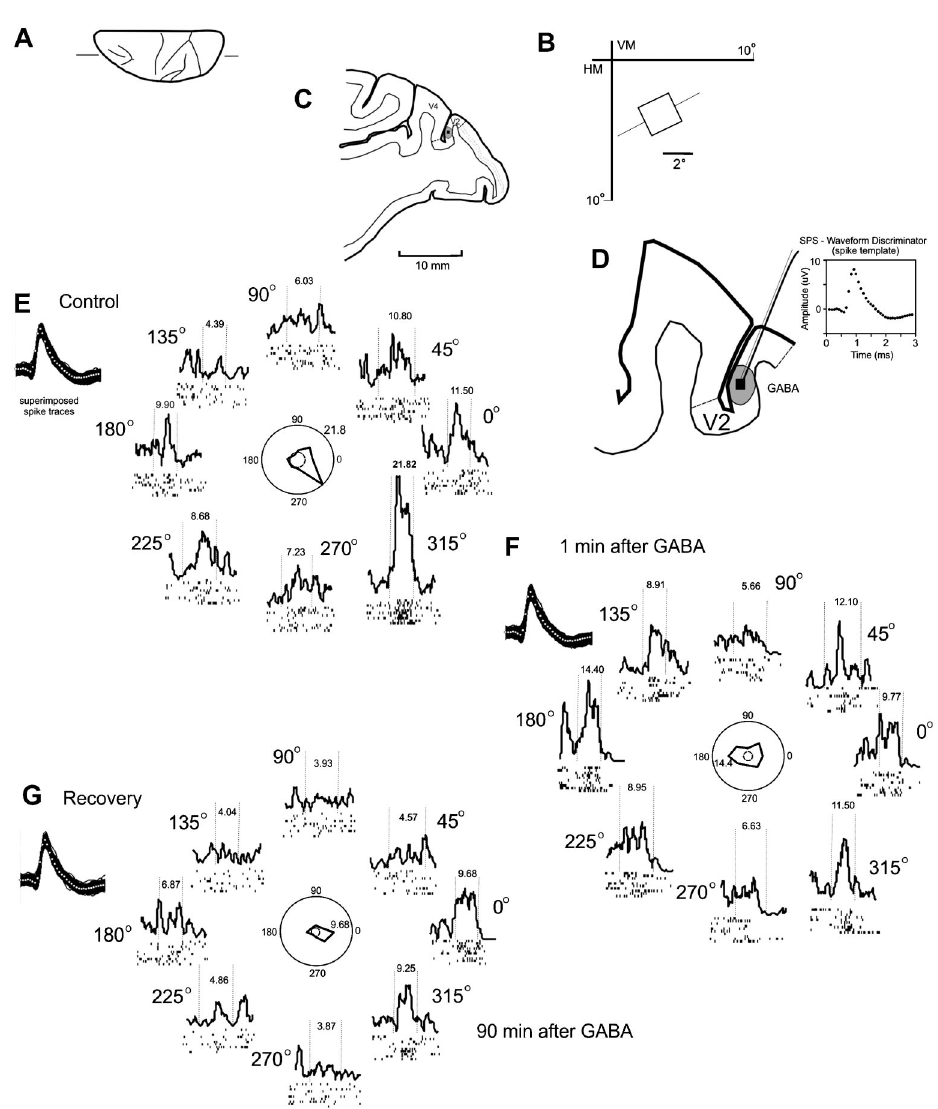
Figure 1. Effect of an injection of 120 nL 0.5 M GABA, on the intrinsic circuit of V2. A , Dorsal reconstruction of the Cebus brain, indicating the levels in the section illustrated in C . B , Location of the receptive field (open square) in V2. HM: horizontal meridian; VM: vertical meridian. D , Parasagittal sections showing the location of the recording and inactivation in V2 (inset: SPS-8701: waveform discriminator spike template). E , Direction selectivity of a V2 neuron prior to GABA inactivation of V2. The polargrams illustrate the unidirectional neuron peak firing rate elicited by bars moving in 8 directions orthogonal to the preferred orientation. Left inset: superimposed spike waveforms (black solid lines) and spike template (white dots). Spike density function and spike rasters from 10 trials are illustrated for each direction. F , Loss of direction selectivity 1 min after GABA inactivation (P , 0.05, one-way ANOVA). G , Recovery, 90 min after GABA